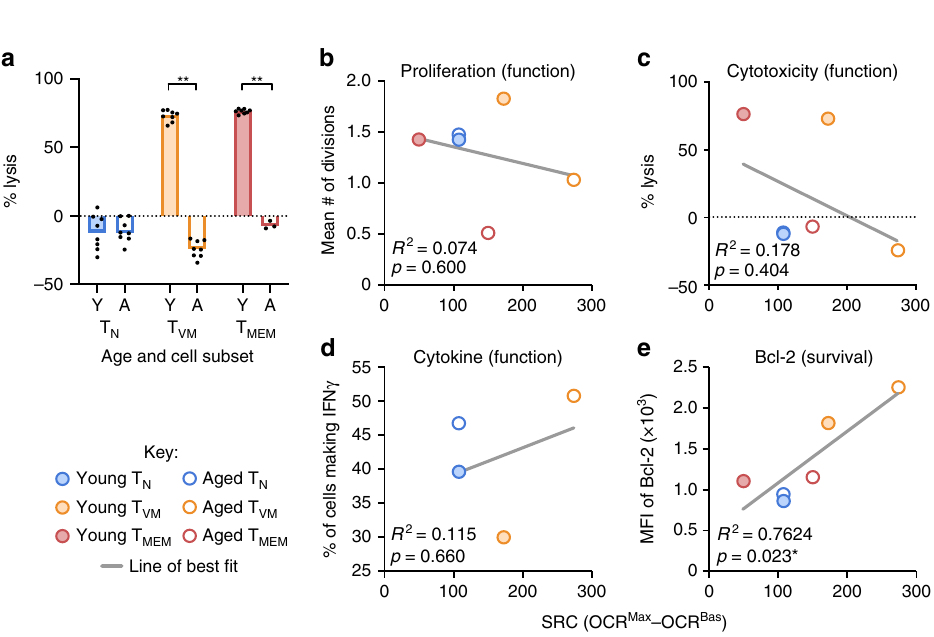
Fig. 4 SRC correlates with Bcl-2 expression but not with CD8 + T cell functionality. a Percent lysis of OVA-loaded targets by sorted T N , T VM and T MEM cells from young or aged OT-I mice ( n = 3 – 8). * Indicates p ≤ 0.05, ** indicates p ≤ 0.01, unpaired t test, data are representative of at least 3 individual experiments. Simple linear regression analyses of mean SRC from Fig. 1b against b the mean number of divisions of sorted CD8 + T cells following 60 h TCR stimulation from ref. 17 , c the average percent lysis from ( a ), d the average proportion of sorted CD8 + T cells making IFN- γ at 36 h after TCR stimulation from ref. 17 , and e the median fl uorescence intensity (MFI) of Bcl-2 expression from ref. 17